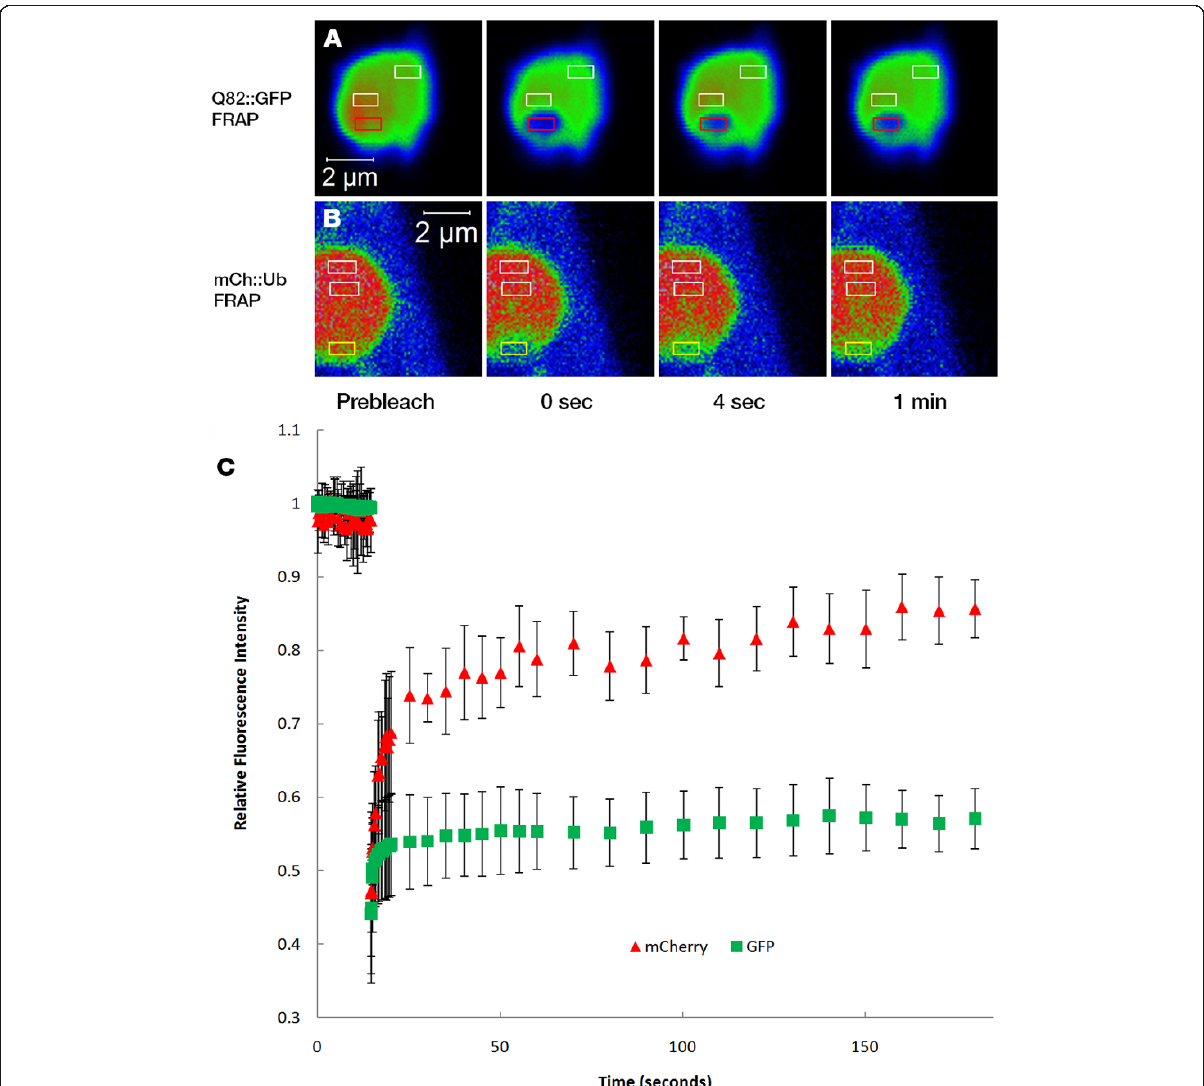
Figure 6 FRAP analysis of mCherry::ubiquitin and Q82::GFP in polyglutamine aggregates reveals differential mobility of ubiquitin and polyglutamine proteins within aggregates . Worms co-expressing an mCherry::ubiquitin fusion protein with Q82::GFP were subjected to FRAP using a confocal laser scanning microscope system. Fluorescence intensity is indicated by a heat map of either Q82::GFP ( A ) or mCherry:: ubiquitin ( B ). Red or yellow rectangles indicate regions to where bleaching was directed. White rectangles indicate regions that were used to control for acquisition photobleaching. Measurements of fluorescence recovery were taken every 0.1 s for 3 minutes. Quantitative analysis ( C ) of fluorescence recovery in bleached regions indicates higher overall mobility of mCherry::ubiquitin fusion protein when compared to Q82::GFP protein. Data plotted are the mean ±